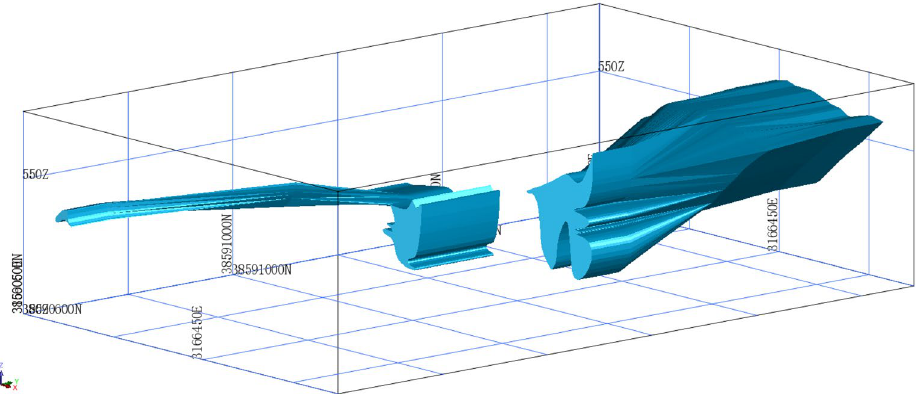
Figure 1. The 3D solid model of the ore